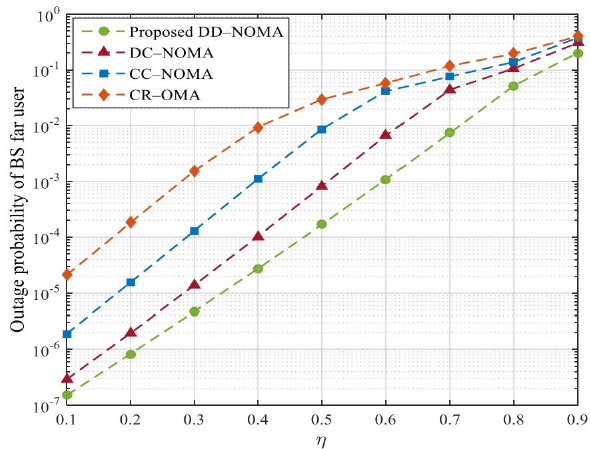
Figure 10. Outage probability of BS far users under different η .